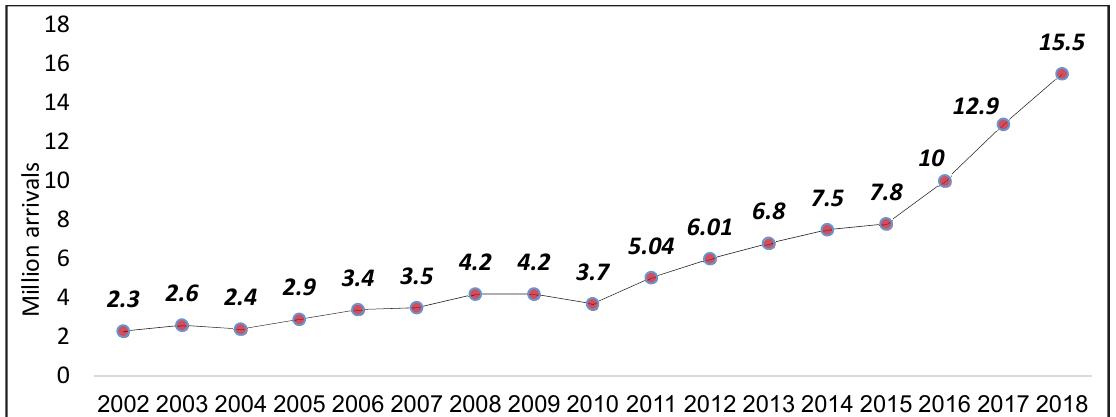
Fig. 1. The annual number of foreign tourist arrivals to Vietnam over